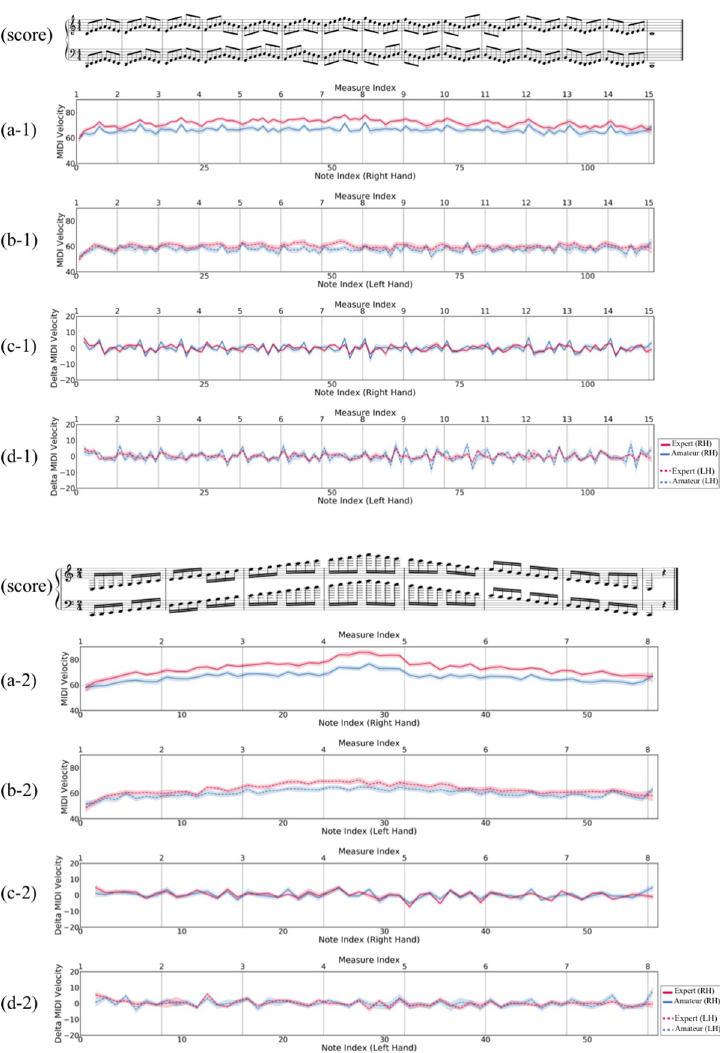
Fig 4. Two graphs that illustrate Velocity and its Delta of the performers between the two pieces. Each feature value is averaged among all of the performers in each proficiency group and is shown as a line in each graph. The shaded area around the line refers to the range of standard error for each note. The corresponding music scores are aligned with the graphs’ timeline to show how the feature values change relative to the musical patterns. In each graph, the red line indicates the expert group, and the blue line indicates the amateur group. The top musical score is "Hanon Exercises No. 1", and the bottom musical score is "C-Major scale". (a) and (c) show the right hand (RH)’s results with the solid lines, and (b) and (d) show the left hand (LH)’s results with the dotted lines. The boundaries of the measures are also depicted as vertical lines in the